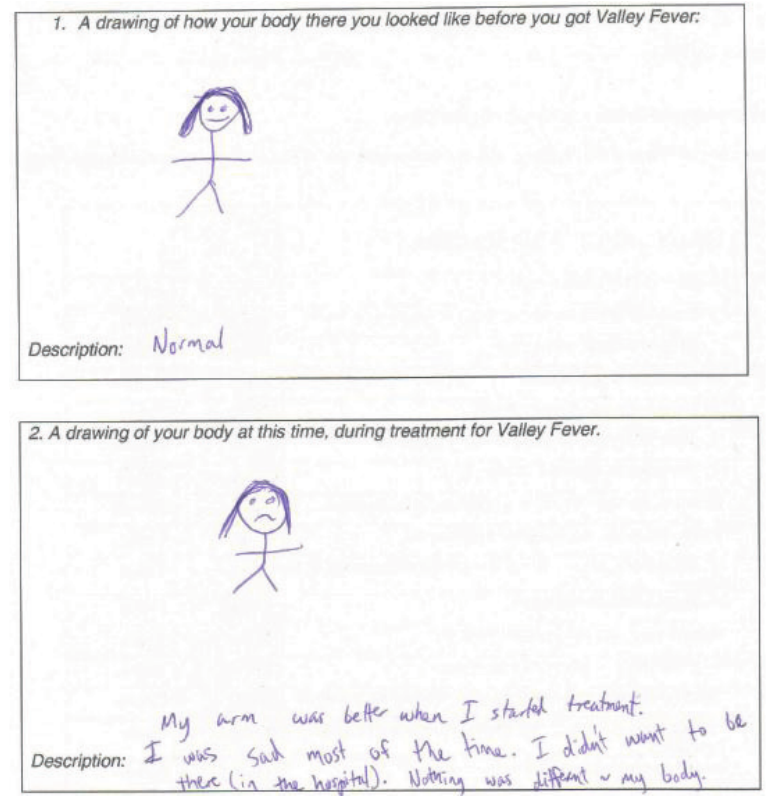
Figure 4. Drawing of a child with coccidioidomycosis with an asymptomatic